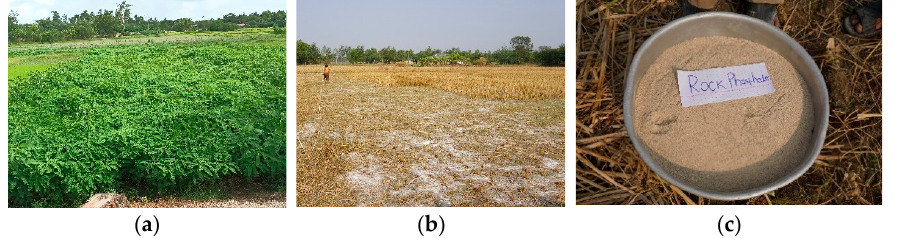
Figure 4. Acid saline soil management by green manuring and application of soil amendments in the Sundarbans region of the Ganges Delta: ( a ) Green manuring with Sesbania aculeata ; ( b ) Application of lime before sowing of Rabi crops; ( c ) Rock phosphate an alternative soil amendment. Source: